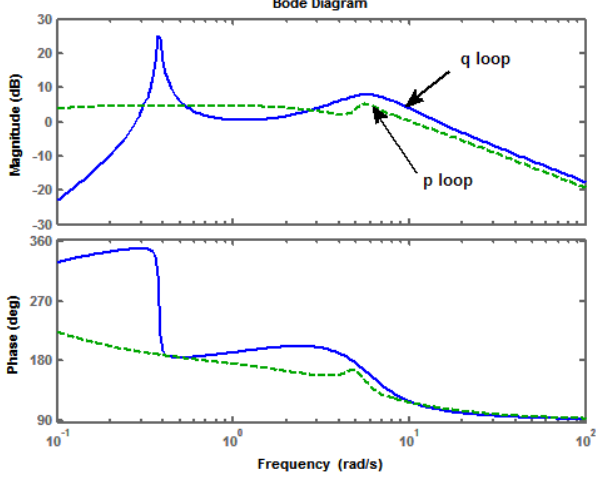
Figure 2. Bode Diagrams for the Transfer Functions of Equations (4) and (5).